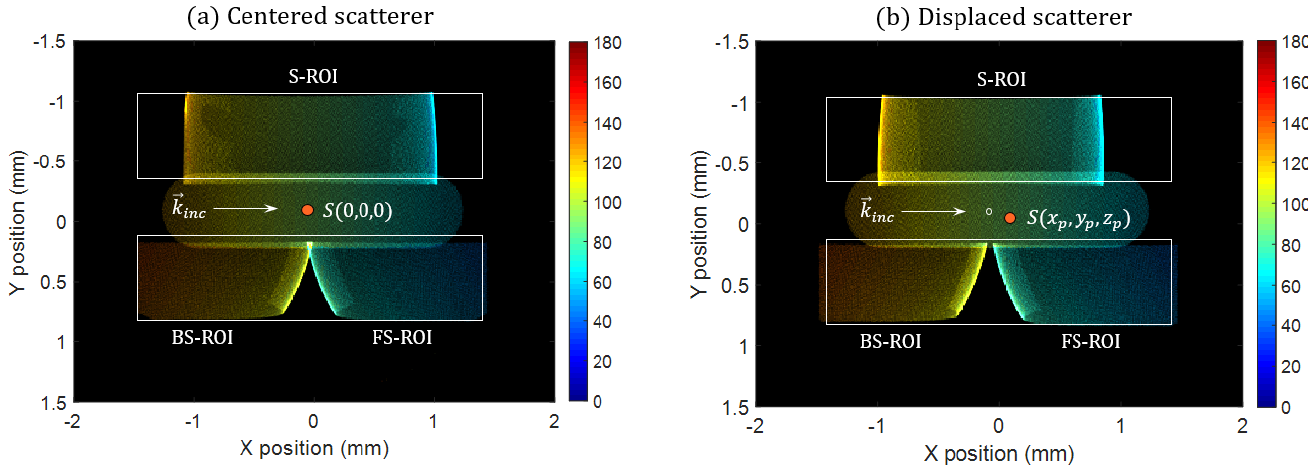
Figure 11. Angular response (in degrees) of the optical system evaluating ( a ) a centered scatterer and ( b ) a displaced scatterer.